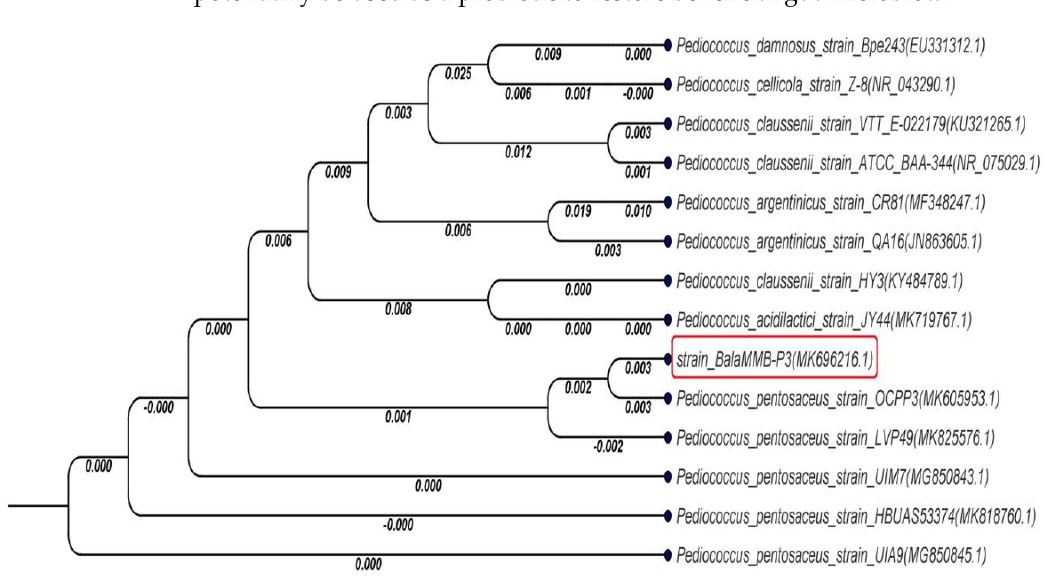
Figure 1. Phylogenetic tree based on 16S rDNA gene sequence showing the relationship between Pediococcus strains and species belonging to the genus Pediococcus. The highlighted red box indicated the species identified in the study.